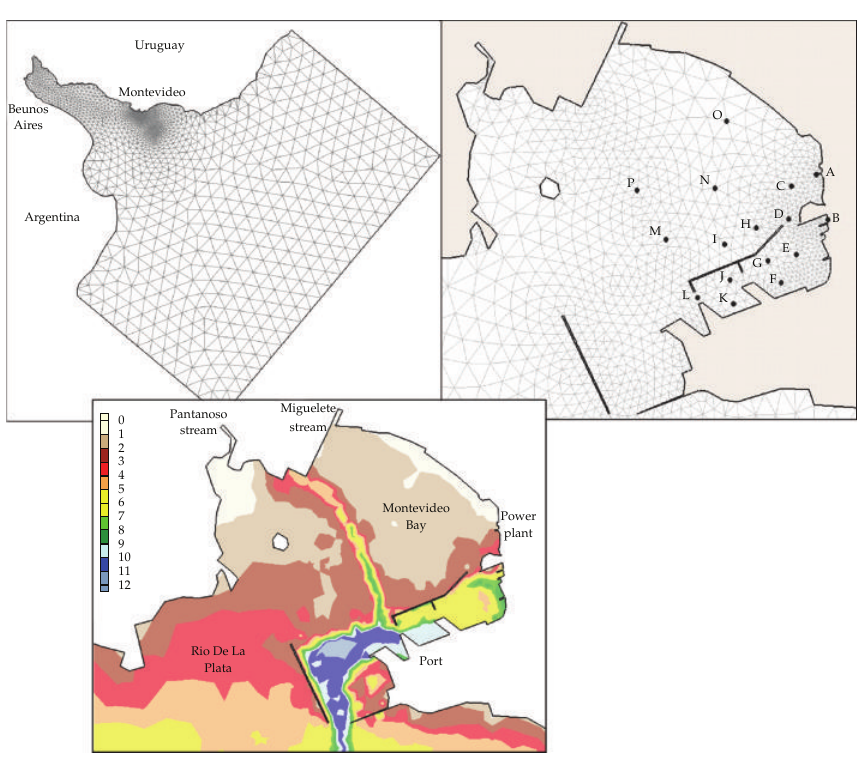
Figure 3: General and detail in Montevideo Bay of the finite element model grid and bathymetry detail in Montevideo